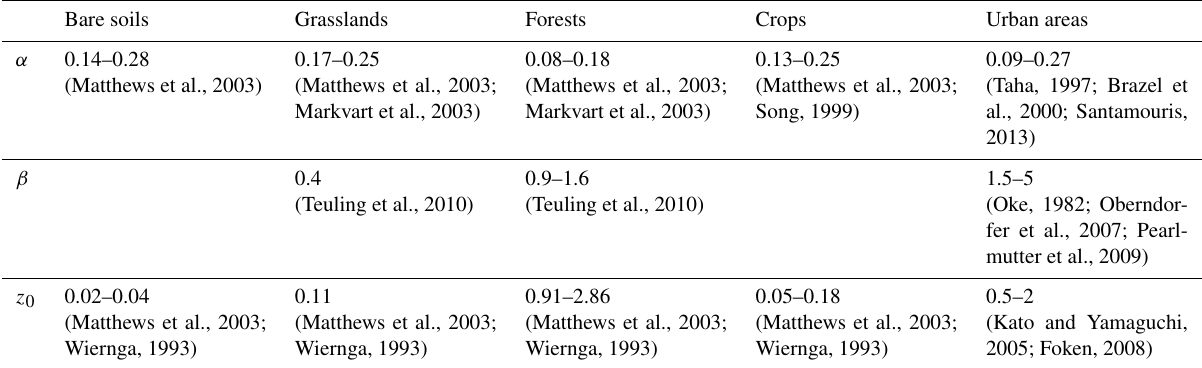
Table 1. Typical values of snow-free albedo ( α – %), Bowen ratio ( β – %), and roughness length ( z 0 – m) for various surface land cover